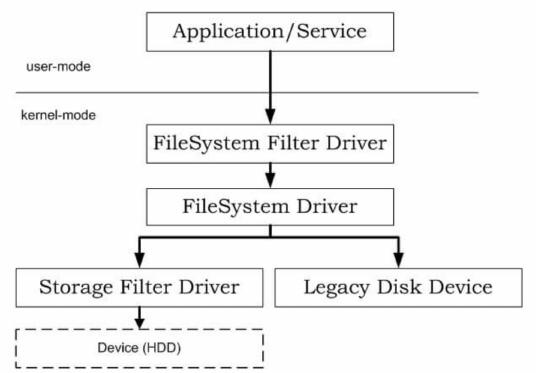
Figure 1. Structure of a file system filter